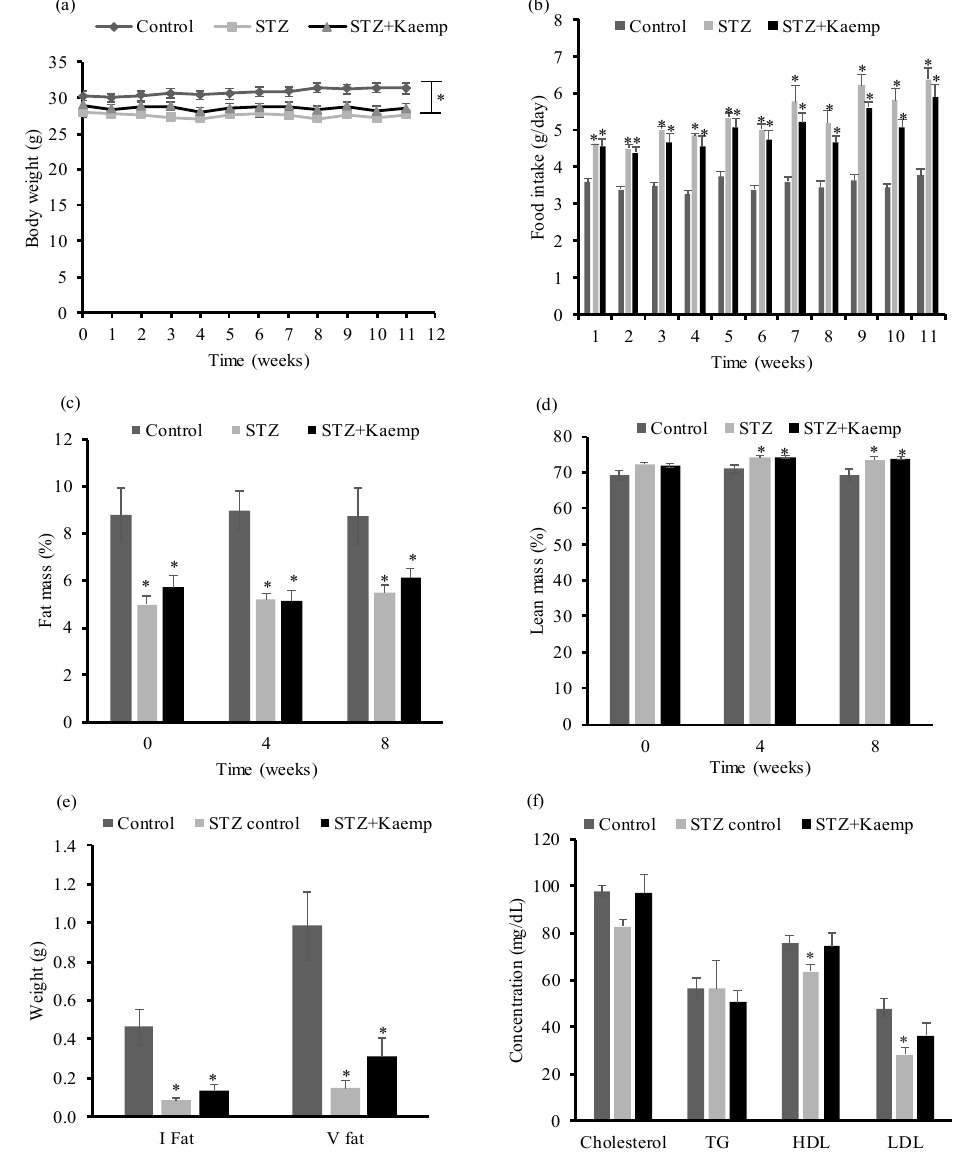
Figure 2. Kaempferol treatment for 12 weeks did not alter BW, calorie intake, or body composition, but restored lipid profiles in STZ-induced diabetic mice. ( a ) BW of the individual mouse was measured weekly. ( b ) Food intake was recorded weekly, and the average daily food intake was calculated. Body composition including fat mass ( c ), and lean mass ( d ) were measured at 0, 4, and 8 weeks of treatment. At the end of the study, ( e ) inguinal and visceral fat were weighed and ( f ) plasma lipid profile were analyzed. Data are shown as Mean ± SEM ( n = 9). * p < 0.05 vs. Control nondiabetic mice. Control: nondiabetic mice; STZ: STZ-induced diabetic mice; STZ + Kaemp: STZ-induced diabetic mice treated with kaempferol (50 mg/kg